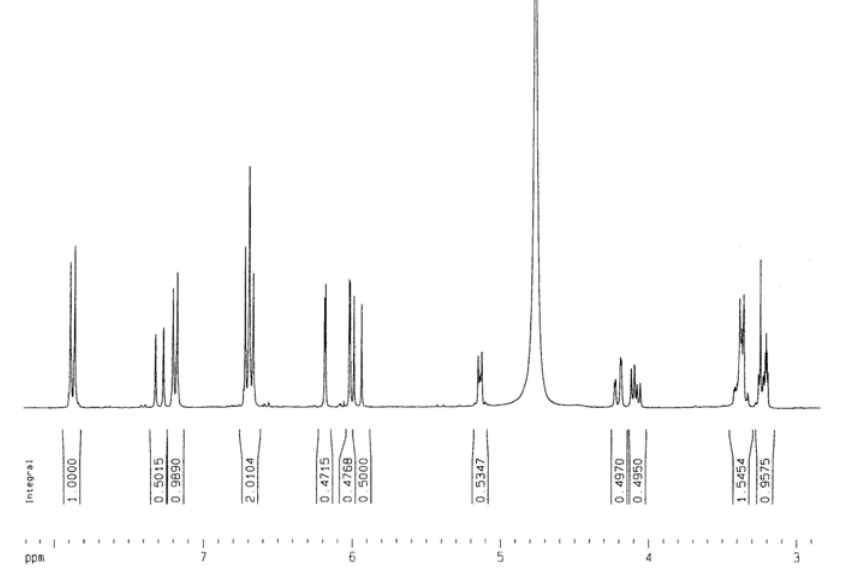
Figure 4. 13 C-NMR spectrum of compound 1 (CD